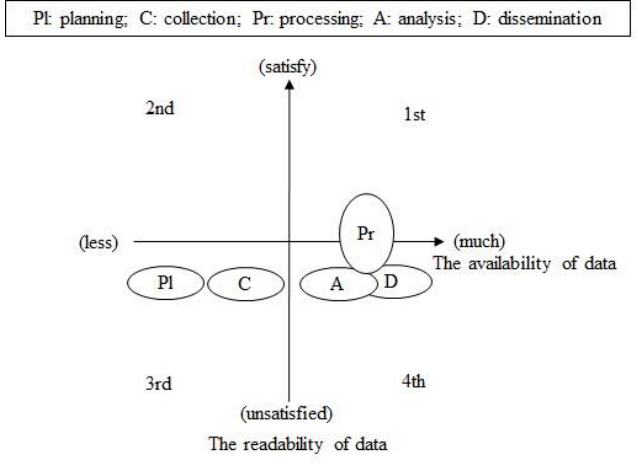
Figure 4. Data Figure 4. Data readiness.